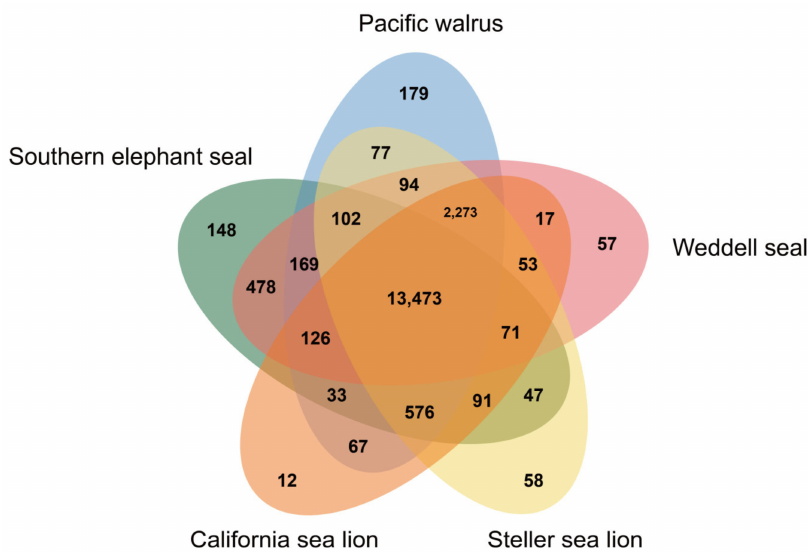
Figure 4. Venn diagram representing paralogous and orthologous groups between Southern elephant seal ( Mirounga leonina ), Pacific walrus ( Odobenus rosmarus ), Weddell seal ( Leptonychotes weddellii ), Steller sea lion ( Eumetopias jubatus ) and California sea lion ( Zalophus californianus ) obtained with OrthoVenn2. Supplementary Materials: The following are available online at http: // www.mdpi.com / 2073-4425 / 11 / 2 / 160 / s1, Table S1: Lengths of the southern elephant seal genome assembly (over 1Mb). Table S2: Completeness of the southern elephant seal genome assembly evaluated with benchmarking universal single-copy orthologs (BUSCO). Table S3: Mapping of Southern elephant seal genome assembly to California sea lion chromosomes (assembly zalCal2.2). Figure S1: Graph of the k-mer distribution (K = 27) using GenomeScope. Figure S2: Gene ontology (GO). The horizontal axis indicates classes of the second-level GO-annotation, and the vertical axis indicates the number of genes in each class. Figure S3: Statistics of Kyoto Encyclopedia of Genes and Genomes (KEGG) classifications. Figure S4: Eukaryotic Orthologous Groups (KOG) classification of the predicted genes. Results are grouped into 24 functional classes according to their functions. The horizontal axis indicates each class, and the vertical axis indicates the number of genes in each